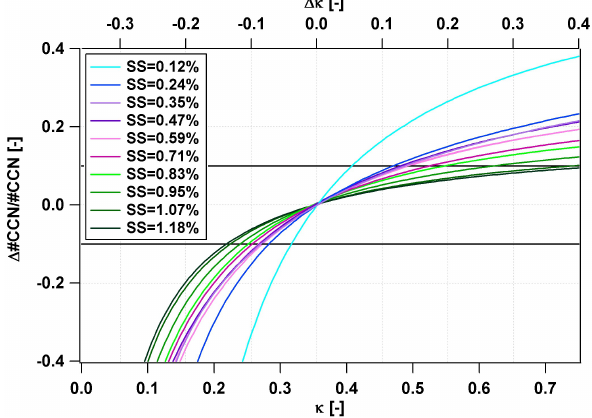
Fig. 8. Time-averaged sensitivity of CCN prediction to changes in assumed κ value. The different colours indicate the different